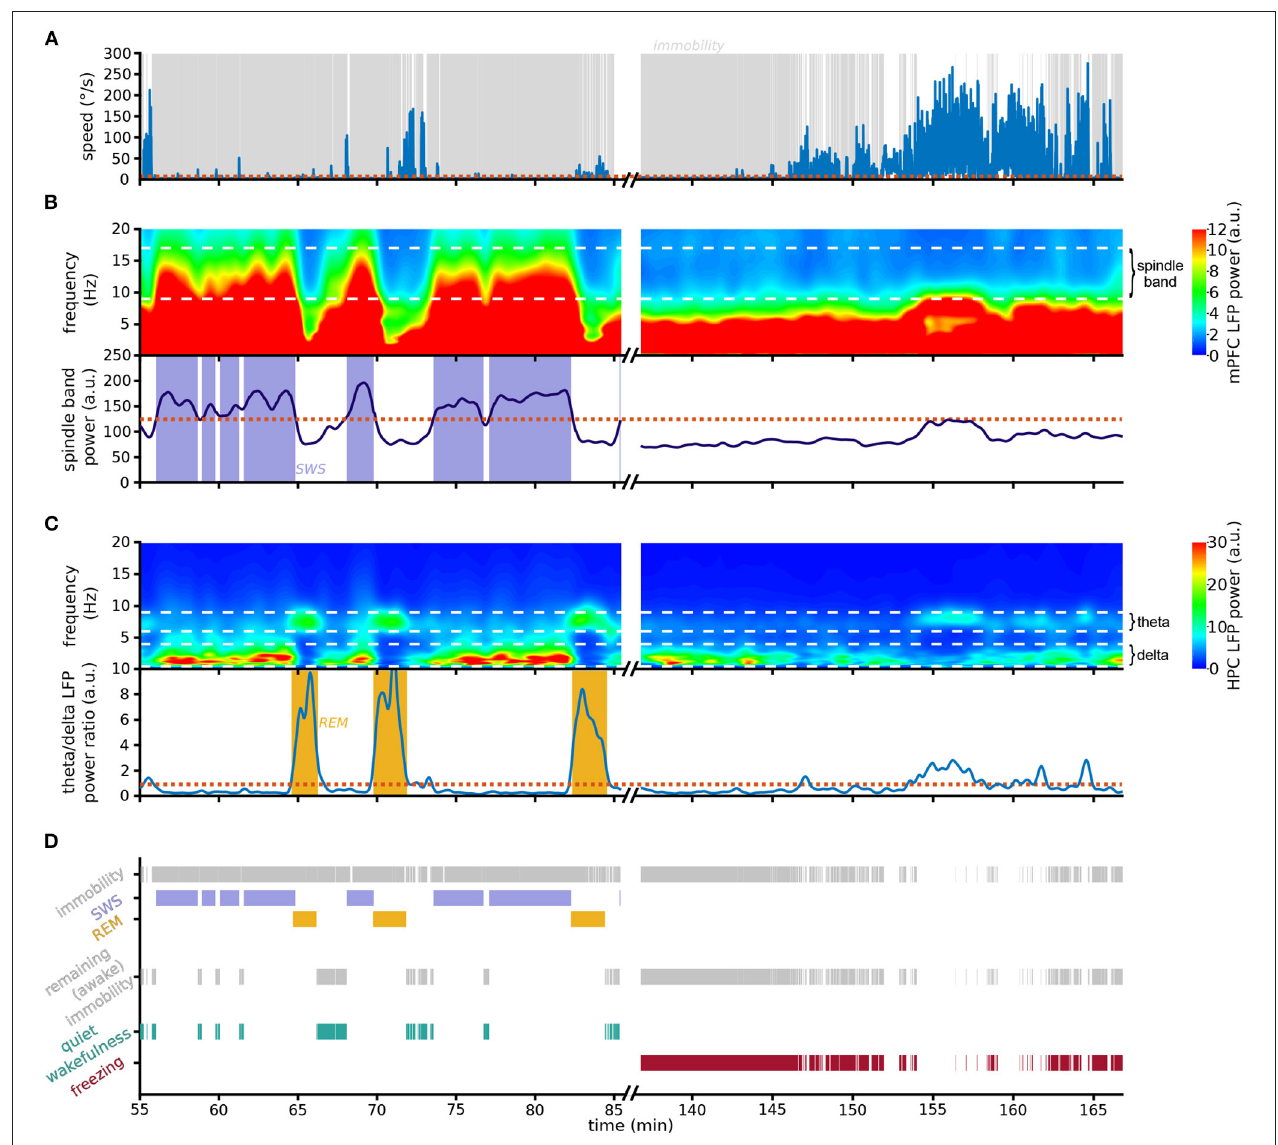
FIGURE 2 | Scoring pipeline. Left: An example 30 min recording in the resting environment; right: an example 30 min recording in context A during the first day of extinction. (A) Animal speed as measured by head movements. (B) (Top) Spectrogram of mPFC LFP activity; white dashed horizontal lines: boundaries of spindle frequency band. Note the prominent spindle band activity recorded in the rest epoch but absent in the conditioning environment. (Bottom) Smoothed spindle band power. Red dotted line: threshold used to detect SWS; blue shading: detected SWS periods. (C) (Top) Spectrogram of HPC LFP activity; white dashed horizontal lines: boundaries of delta and theta frequency bands. Note that in the resting session theta-dominating periods immediately follow the high-spindle power SWS periods depicted above. (Bottom) Theta/delta ratio; red dotted line: threshold used to detect REM sleep; yellow shading: detected REM sleep periods. (D) Detection chart. (Top) All detected immobility, SWS and REM periods. (Middle) Immobility periods not identified as either SWS or REM sleep are labeled awake immobility behaviors. (Bottom) Awake immobility periods immediately preceding SWS are classified as quiet wakefulness (green), and the remaining immobility is scored as freezing (red). Note that freezing was the dominating behavior detected during the first 10 min of exposure to the conditioning context